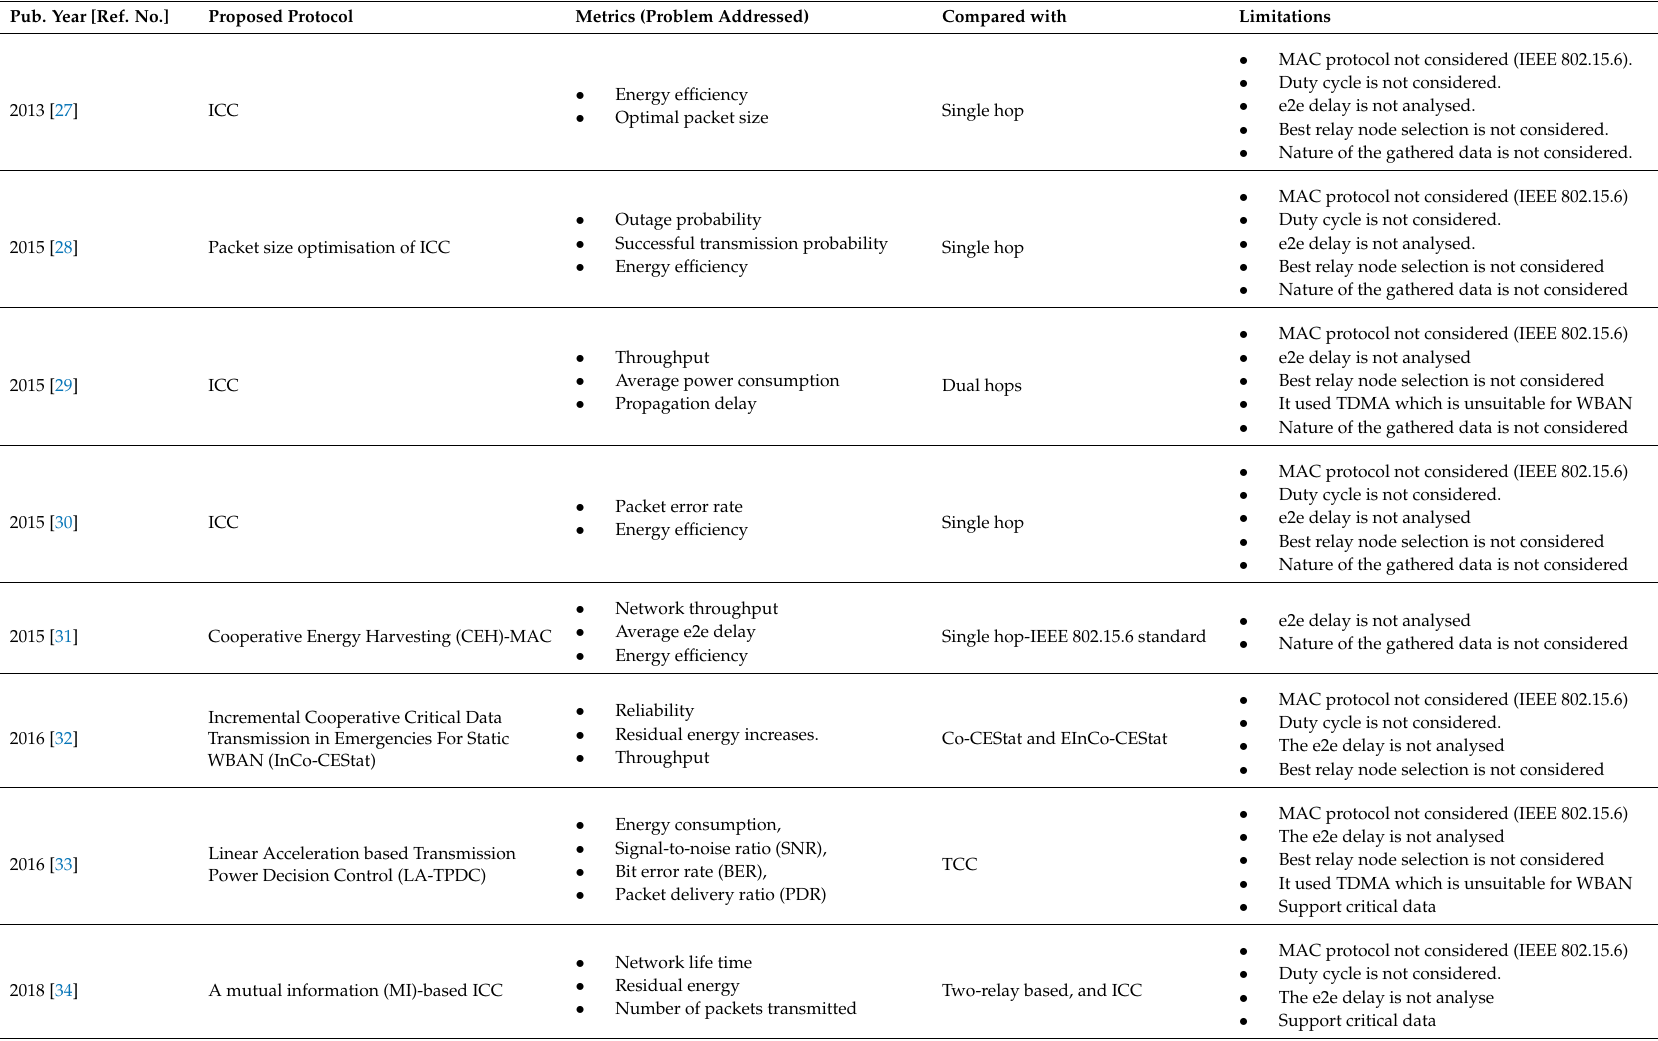
Table 1. Comparison of state of art